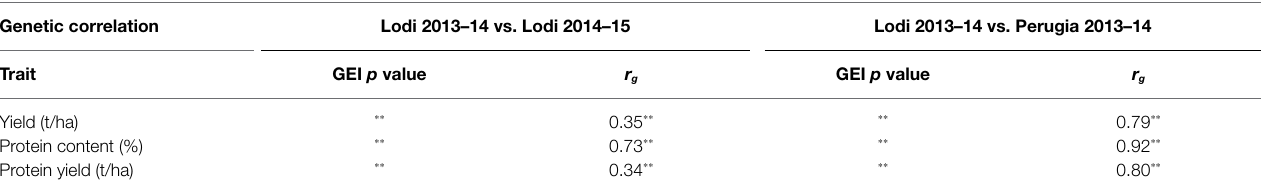
TABLE 4 | Significance of genotype × environment interaction (GEI p value) and genetic correlation for line values across pairs of test environments ( r g ) for traits of 306 pea lines belonging to three connected RIL populations.